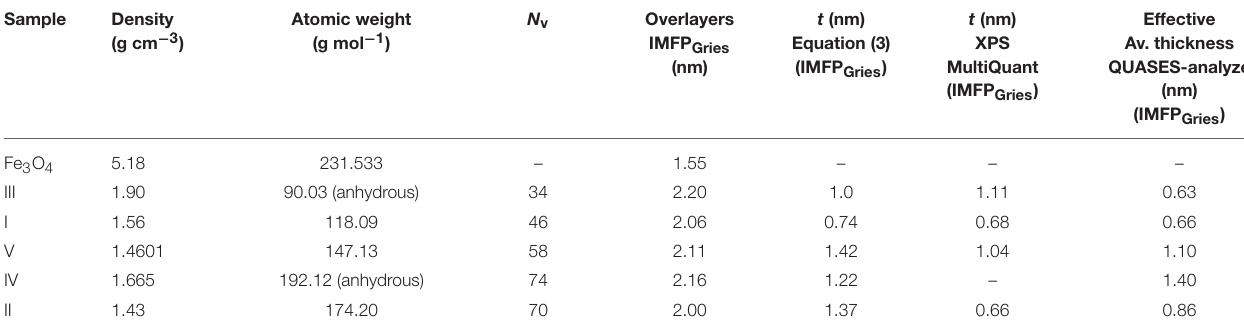
TABLE 3 | Parameters for determining overlayer thickness from XPS MultiQuant (Mohai, 1999-2001, 2004), attenuation equation (Equation 3) (Jablonski and Zemek, 2009), IMFP values for various overlayers from Gries G1 equation (Gries, 1996), and comparison of overlayer thickness values resulting from XPS MultiQuant, attenuation equation and effective thickness from QUASES-Analyze for Fe 3 O 4 MNPs and Fe 3 O 4 f-MNPs I–V. Sample